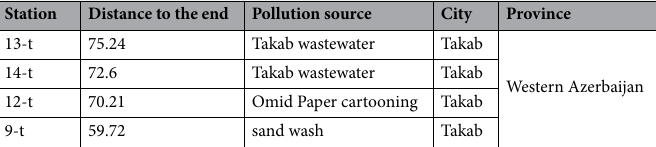
Table 4. Characteristics of polluting sources along the Sarouq reach